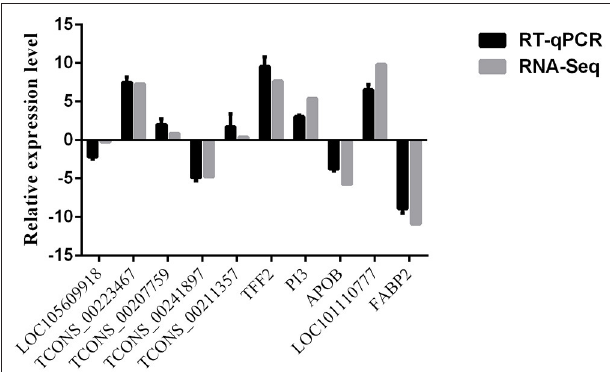
FIGURE 11 | Comparisons of the results of the RNA-Seq and RT-qPCR analyses of selected lncRNAs and mRNAs in AN vs. SE.